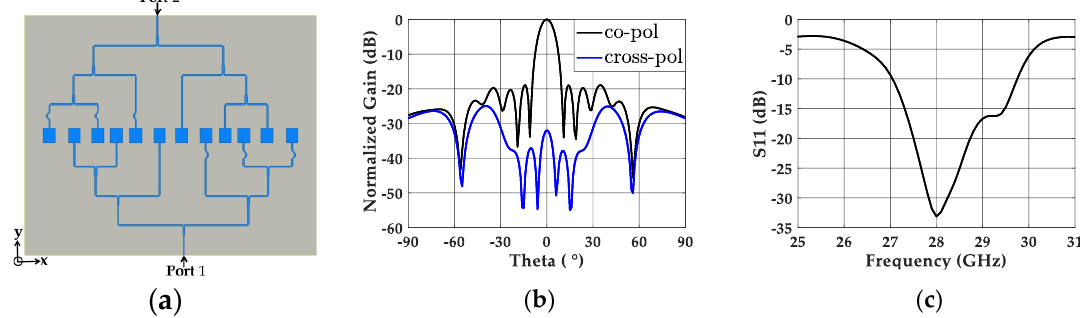
Figure 9. ( a ) Top view of the non-uniformly powered and spaced 12-element patch array. ( b ) Simulated normalized gain of the non-uniformly powered and spaced 12-element patch array with co- and cross-polarization. ( c ) Simulated S 11 of the same antenna array.